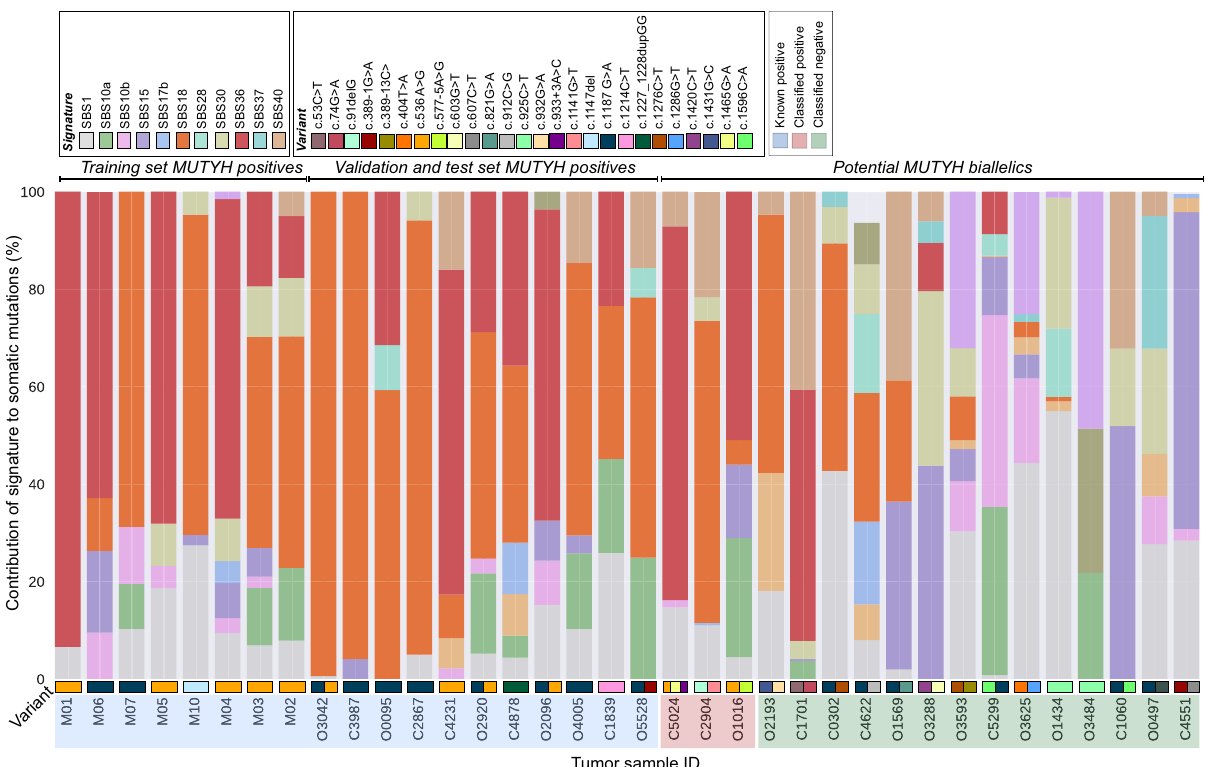
Fig. 2 Observed tumor mutational signature pro fi les for 19 CRCs from germline biallelic MUTYH pathogenic variant carriers, and 17 CRCs carrying more than one MUTYH pathogenic or potentially pathogenic variant but not two pathogenic variants (potential biallelic). All the CRCs from the germline biallelic MUTYH PV carriers exhibit dominant SBS18 and/or SBS36 tumor mutational signature. Source data are provided as a Source Data fi